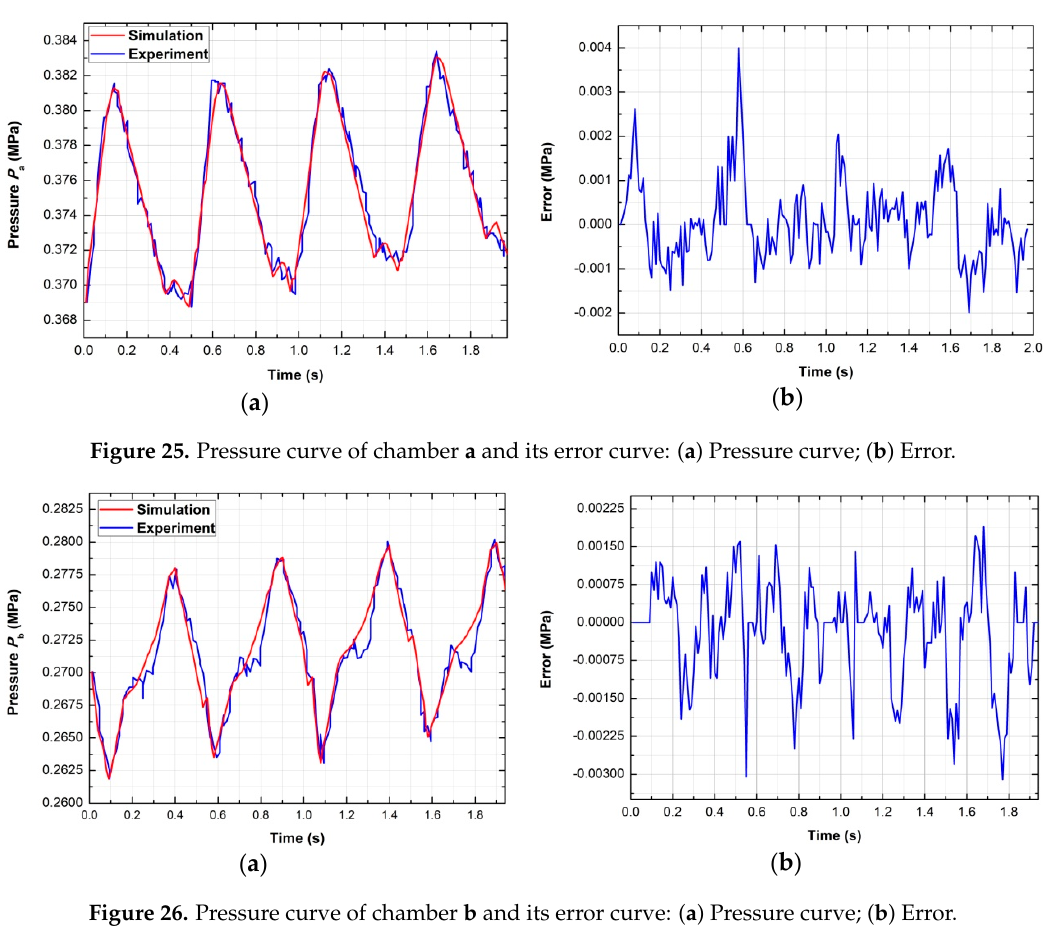
Figure 24. Rotation angle curve and its error curve: ( a ) Rotation angle curve; ( b ) Error.